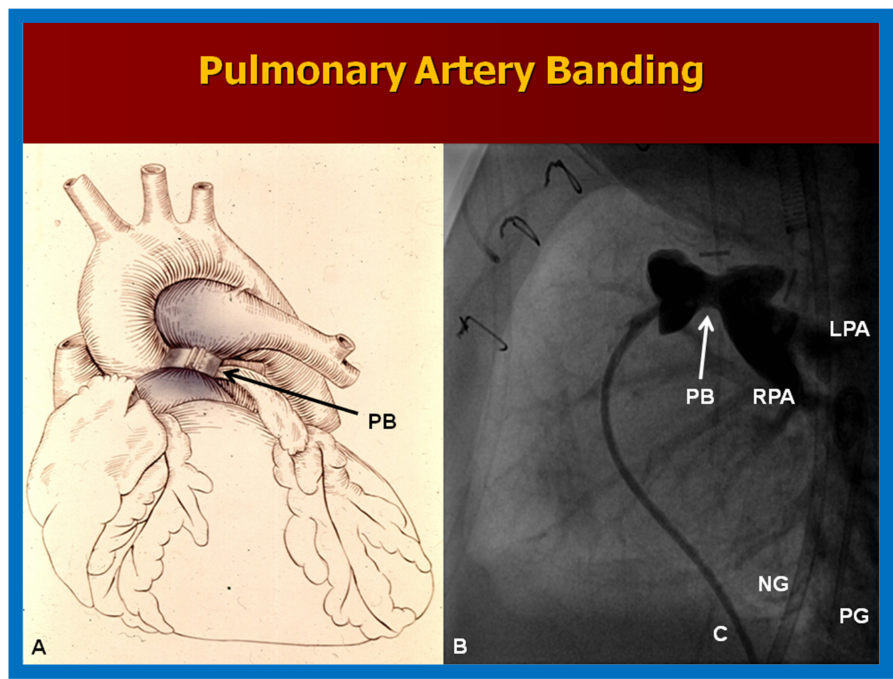
Figure 9. ( A ) Pictorial depiction of pulmonary artery banding (PB) for babies with severely augmented blood flow into the lungs and heart failure. ( B ) Cine image from a pulmonary artery cine-angiogram